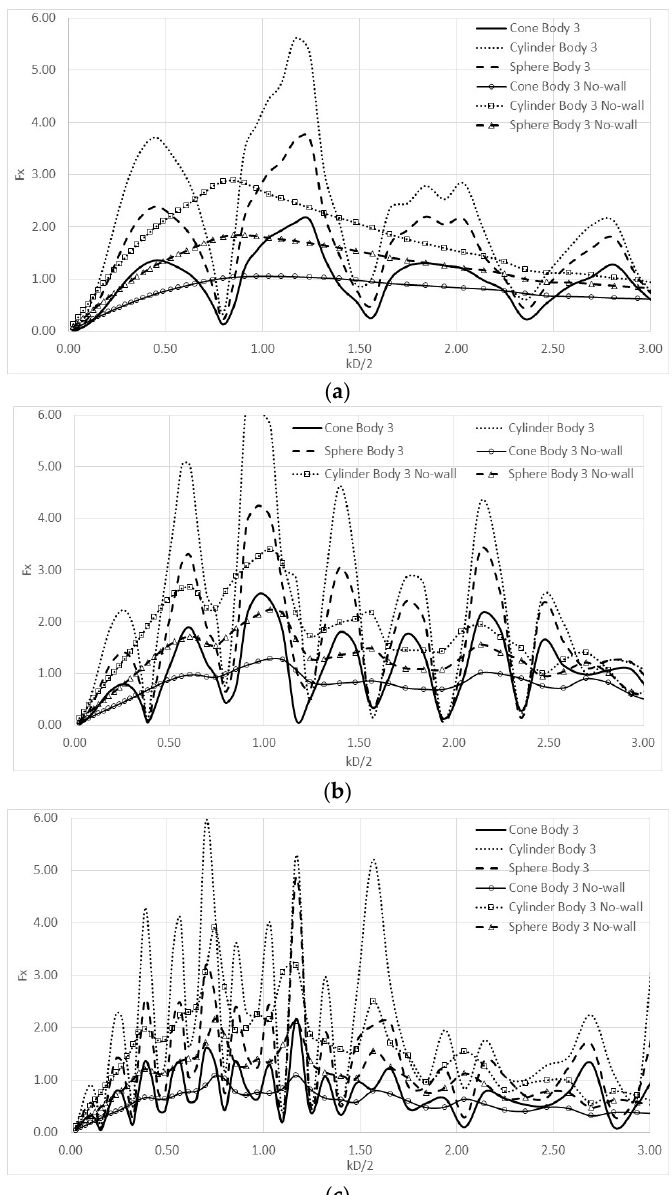
Figure 8. Dimensionless horizontal exciting wave forces acting on the 3rd floater of the arrays plotted against the non-dimensional wave number kD/2, for the three different examined array configurations. Comparison with the surge exciting wave forces on the same floater of the arrays without the presence of the breakwater: ( a ) parallel arrangement, C 1 ; ( b ) rectangular arrangement, C 2 ; ( c ) perpendicular arrangement, C 3 .